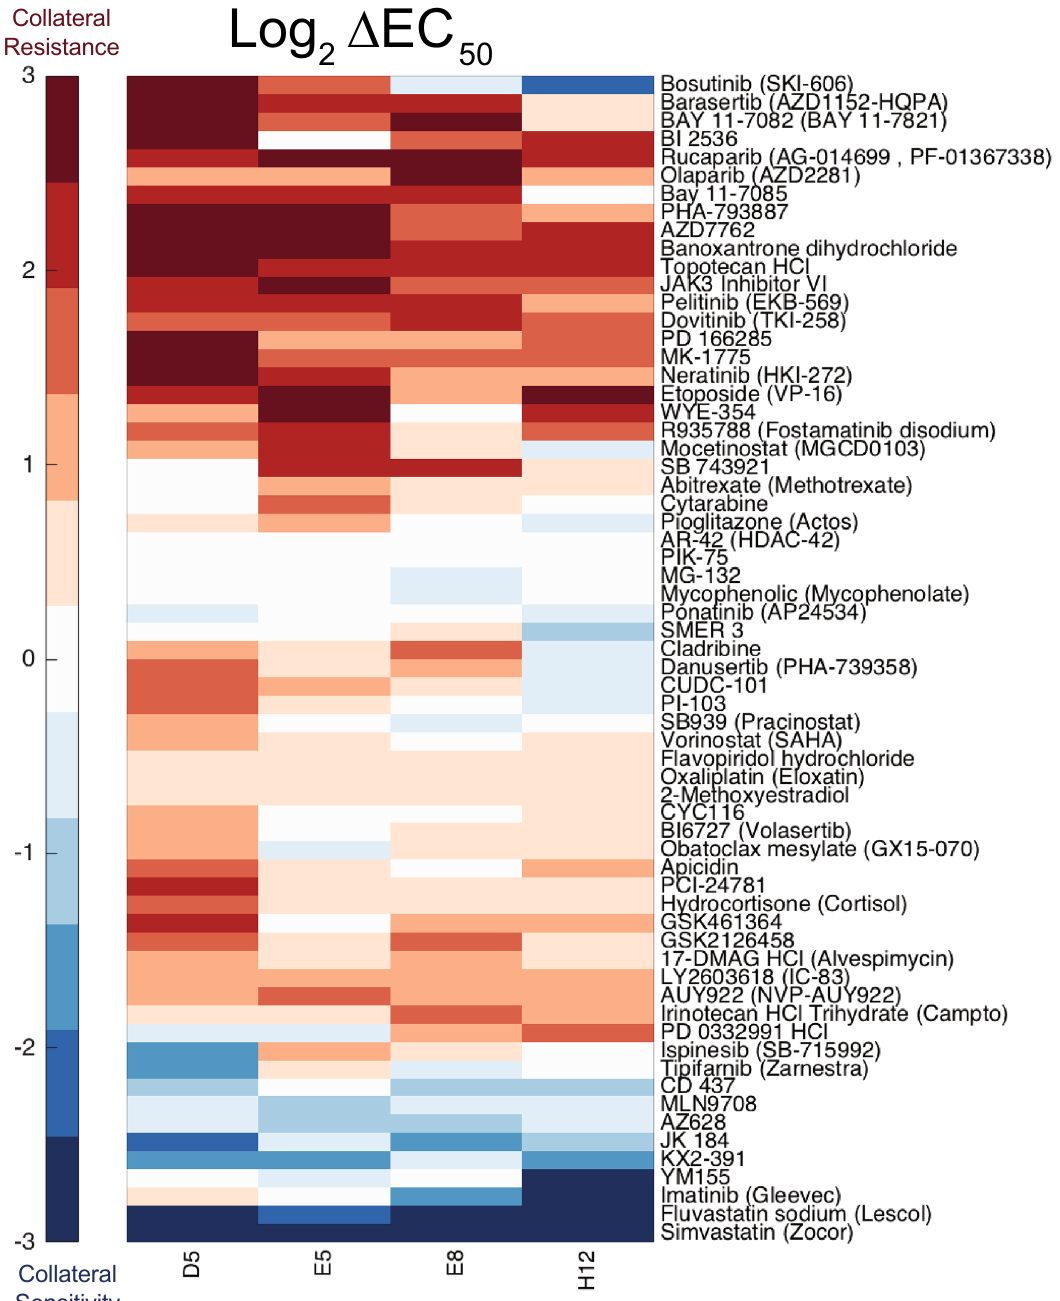
Figure 2. High-throughput drug screen to assess collateral responses to doxorubicin resistance. Cell lines screened are in columns, drugs with collateral effects are in rows. Colors represent the log 2 fold change of the EC 50 of each cell line for a drug relative to the parental cell line’s EC 50 for that same drug. Red represents a case in which the resistant cell line also acquired resistance to a different drug—collateral resistance. Blue represents a case in which the resistant cell line acquired sensitivity to a different drug—collateral